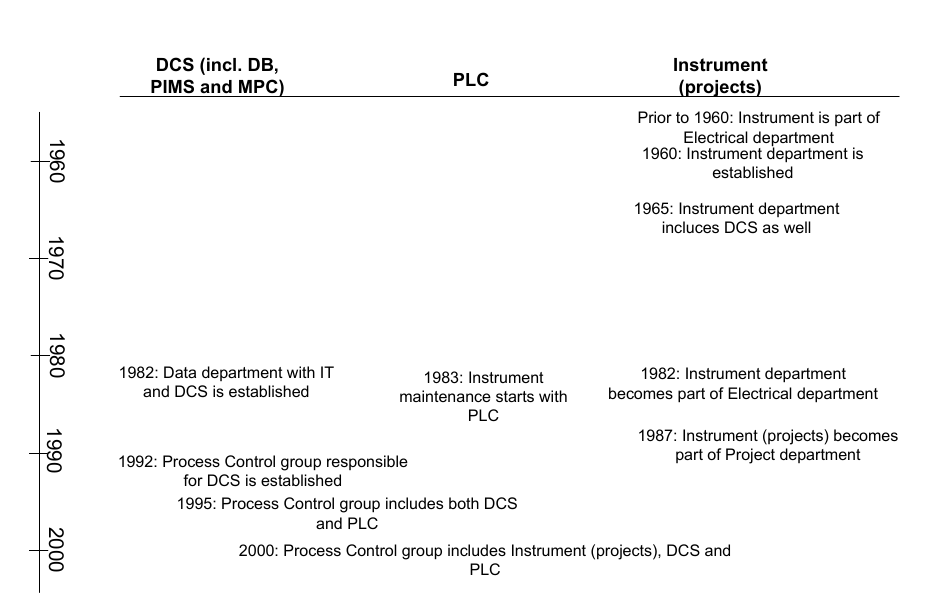
Figure 3: Chronological overview of organization of process control group at Xstrata